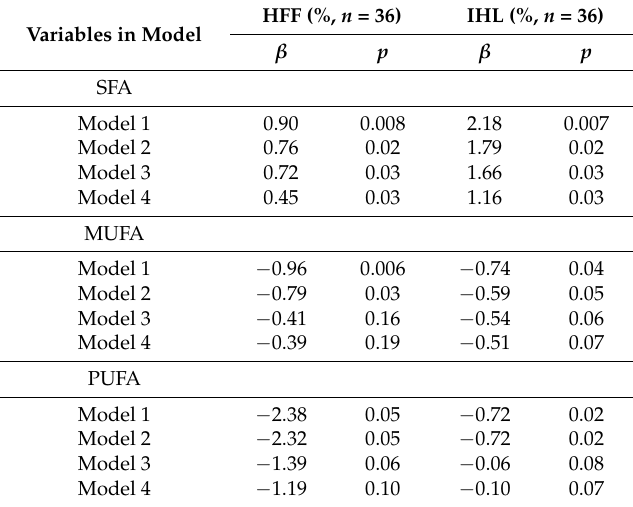
Table 4. Associations between fatty acids intake and HFF and IHL.